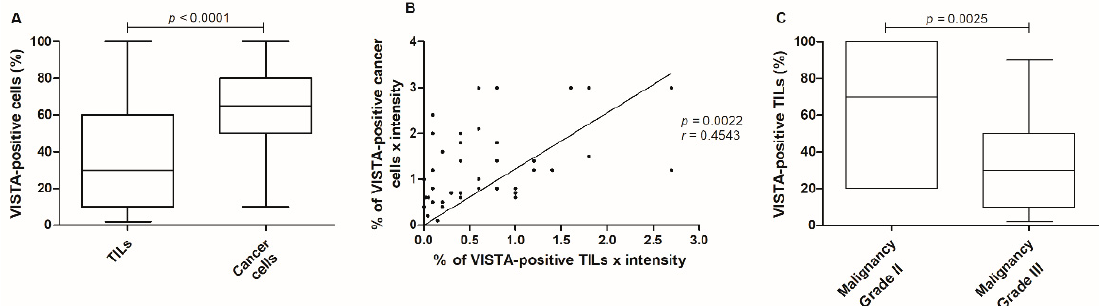
Figure 6. VISTA expression in the feline tumor samples. ( A ) Cancer cells presented a higher VISTA expression when compared to TILs (*** p < 0.0001), ( B ) with a correlation obtained between VISTA expression in cancer cells and TILs (** p = 0.0022). ( C ) Considering the VISTA-positive TILs population, a higher expression was reported in tumors classified with malignancy grade II (** p = 0.0025).